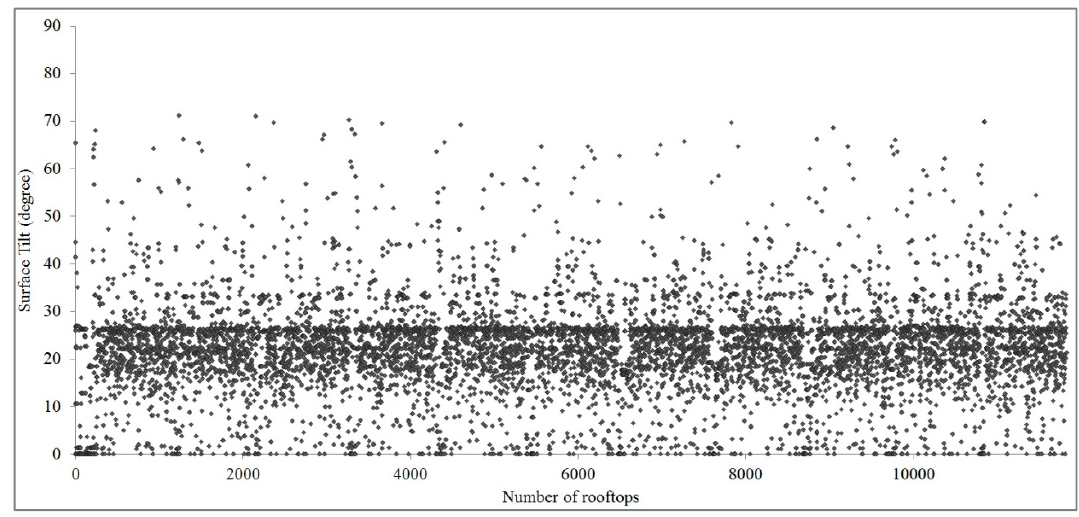
Figure 11. The distribution of surface tilt of all rooftops from a LiDAR tile.